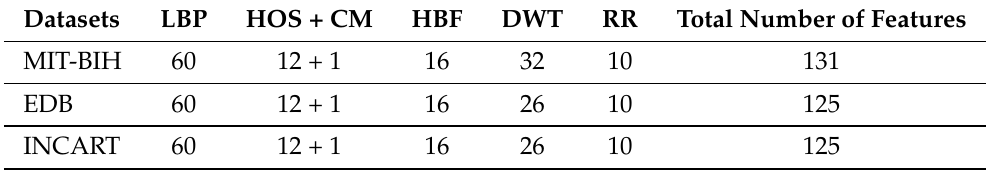
Figure 1. Overview of an early diagnosis and classification of ECG arrhythmia healthcare system. Table 1. Total number of features extracted from the MIT-BIH, EDB, and INCART